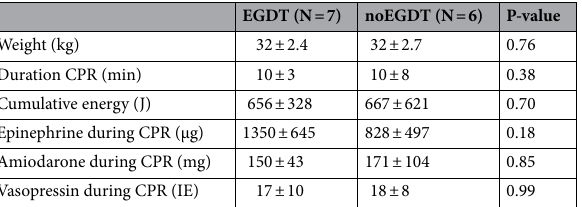
Table 1. Descriptive data. Values are presented as mean ± SD. CPR cardiopulmonary resuscitation.